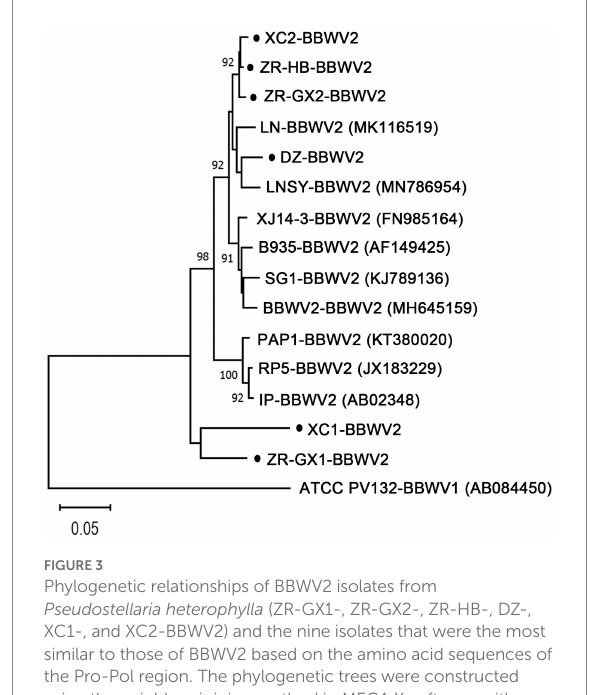
FIGURE 3 Phylogenetic relationships of BBWV2 isolates from Pseudostellaria heterophylla (ZR-GX1-, ZR-GX2-, ZR-HB-, DZ-, XC1-, and XC2-BBWV2) and the nine isolates that were the most similar to those of BBWV2 based on the amino acid sequences of the Pro-Pol region. The phylogenetic trees were constructed using the neighbor-joining method in MEGA X software with a bootstrap of 1,000 replicates. The black dots represent isolates identified in this study. ZR-GX1-, ZR-GX2-, ZR-HB-, DZ-, XC1- and XC2-BBWV2 represent the isolates isolated from the samples collected from Gongxi village (ZR-GX) and Huangbai village (ZR- HB) in Zherong County in Fujian Province, Danzhai County (DZ) in Guizhou Province, and Xuancheng city (XC) in Anhui Province,